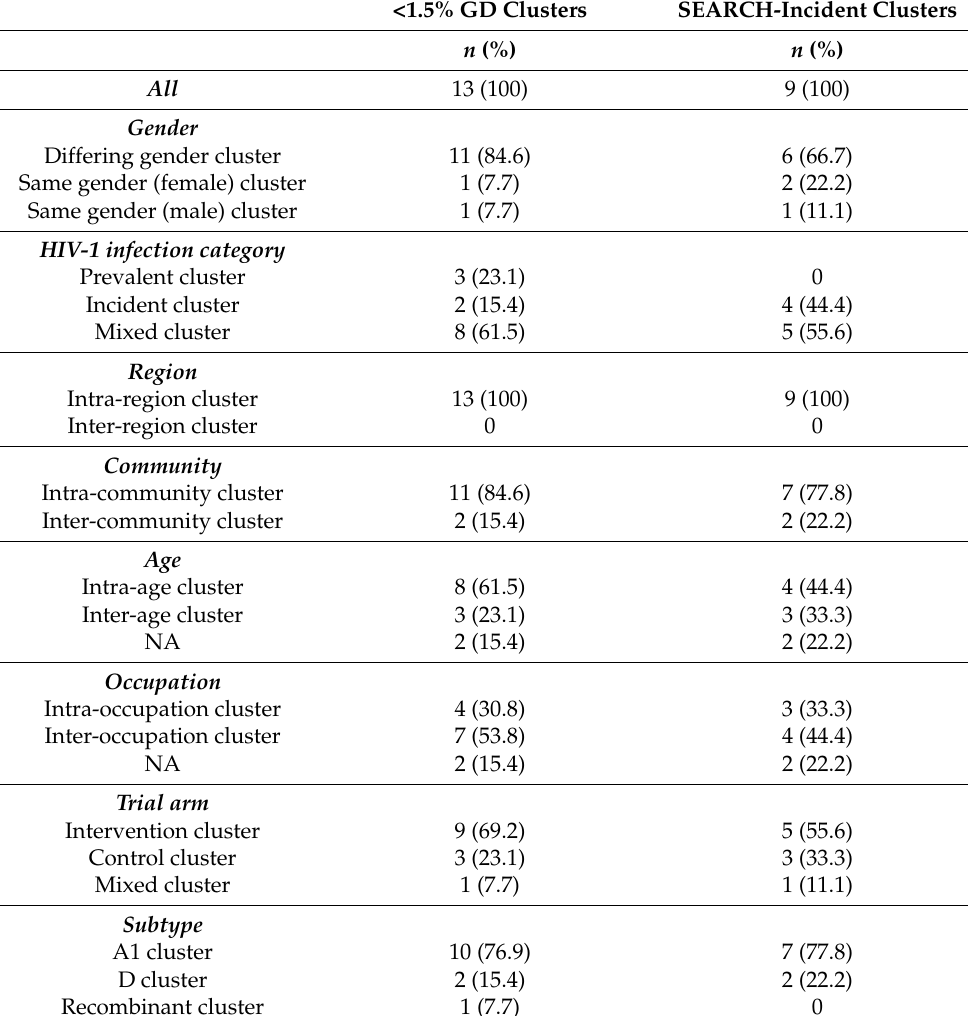
Table 5. Characteristics of SEARCH <1.5% pairwise genetic distance (GD) clusters ( n = 13) and of phylodynamic clusters arising after the start of the SEARCH trial ( n =